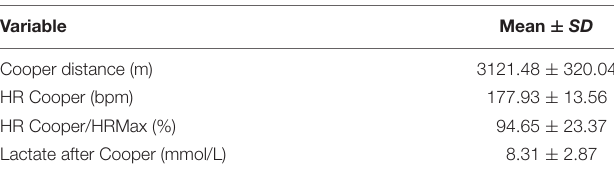
TABLE 1 | Characteristics of the sample ( n =